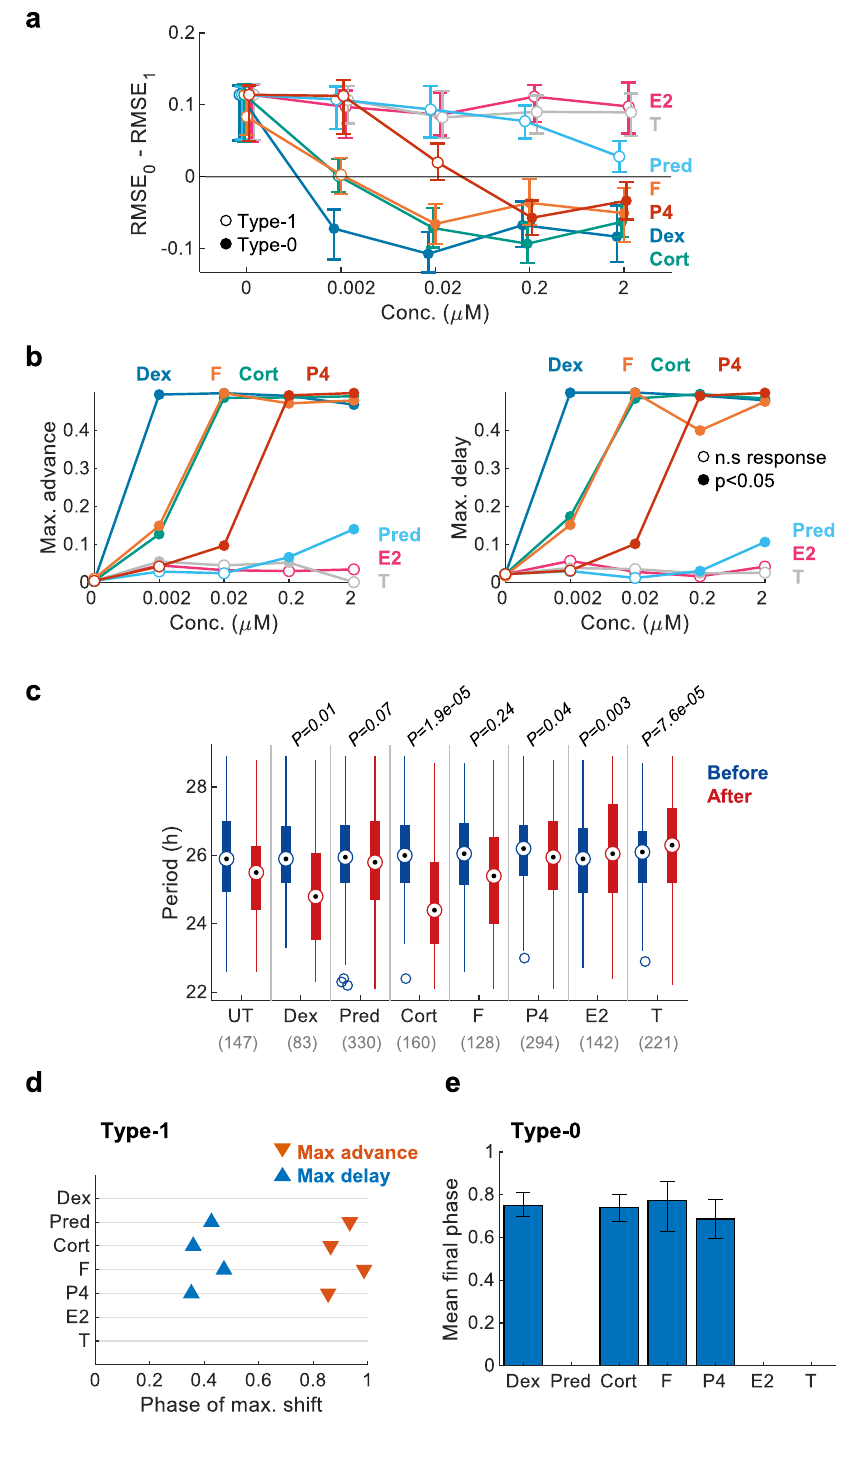
504 – 544nm), and Red (excitation: 565 – 605 nm, emission: 625 – 705 nm). The green channel captures the Rev-VNP reporter, while the red channel captures the H2B-mCherry reporter. Phase-contrast images were only used for general inspection of the population status and were not used further in the analysis. Images were taken every 60 min for a total duration of 9 days, in 16 fi elds-of-views per well. After 4.5 days since the beginning of imaging, plates were taken out of the incubator, treated with the agent of choice by adding it on top of the existing media, and placed back in the microscope. The recording was then continued for another 4.5 days. Speci fi c compounds that were used for resetting experiments are detailed